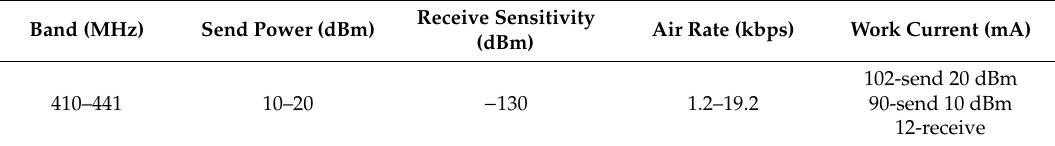
Table 2. The parameters of LoRa module. Figure 6. Software used in test: ( a ) measurement software [39] ; ( b ) configuration software [40].